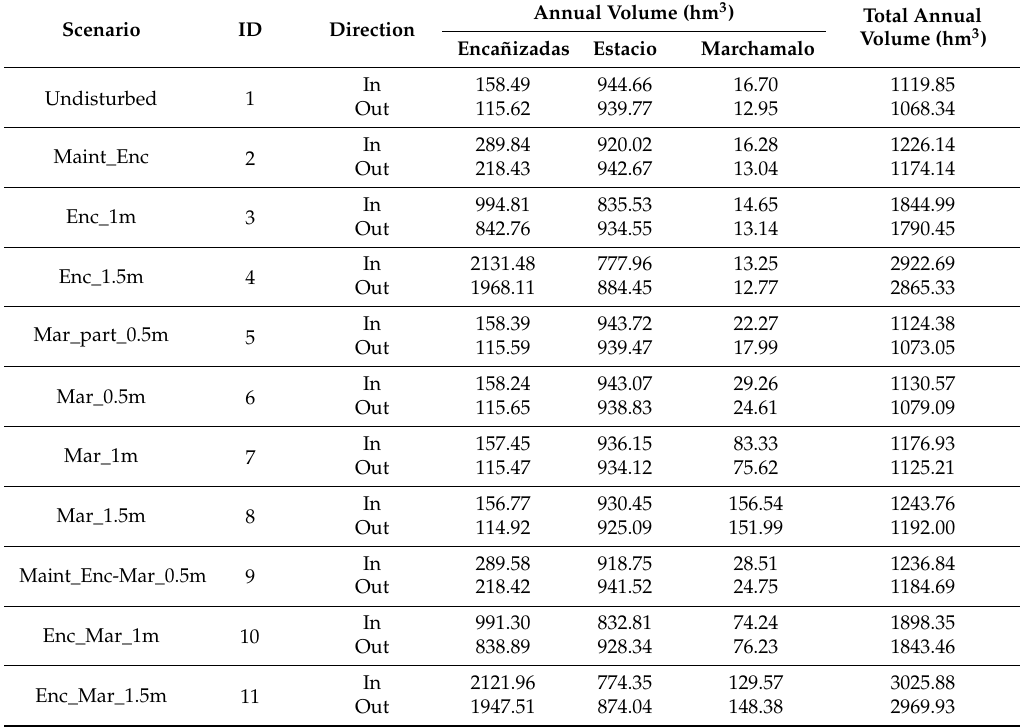
Table 6. Individual volume in and out each channel and total volume exchanged during one